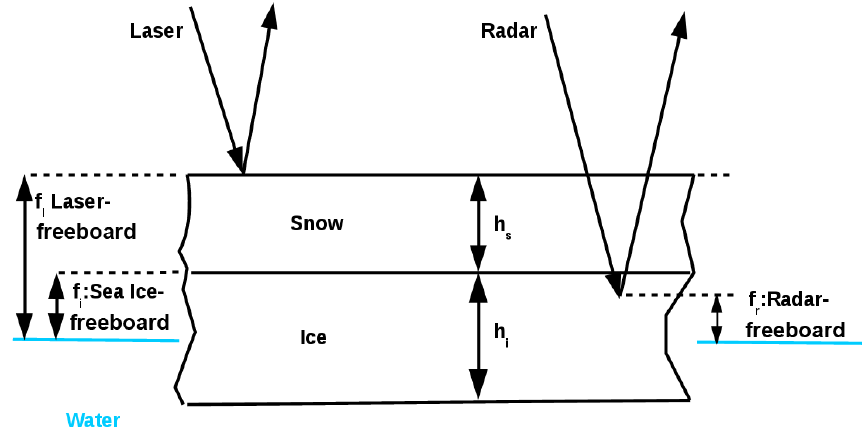
Figure 11. Schematic illustration of sea ice thickness and different freeboard